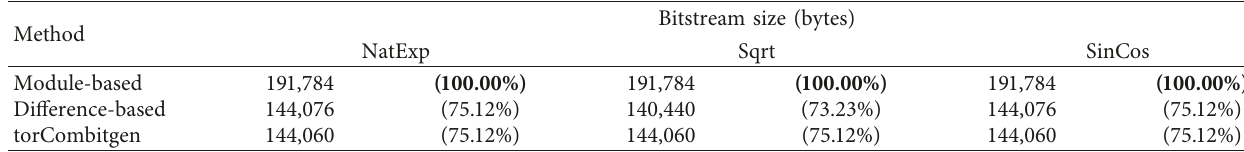
Table 5: Bitstream sizes in the ViSARD-swapping